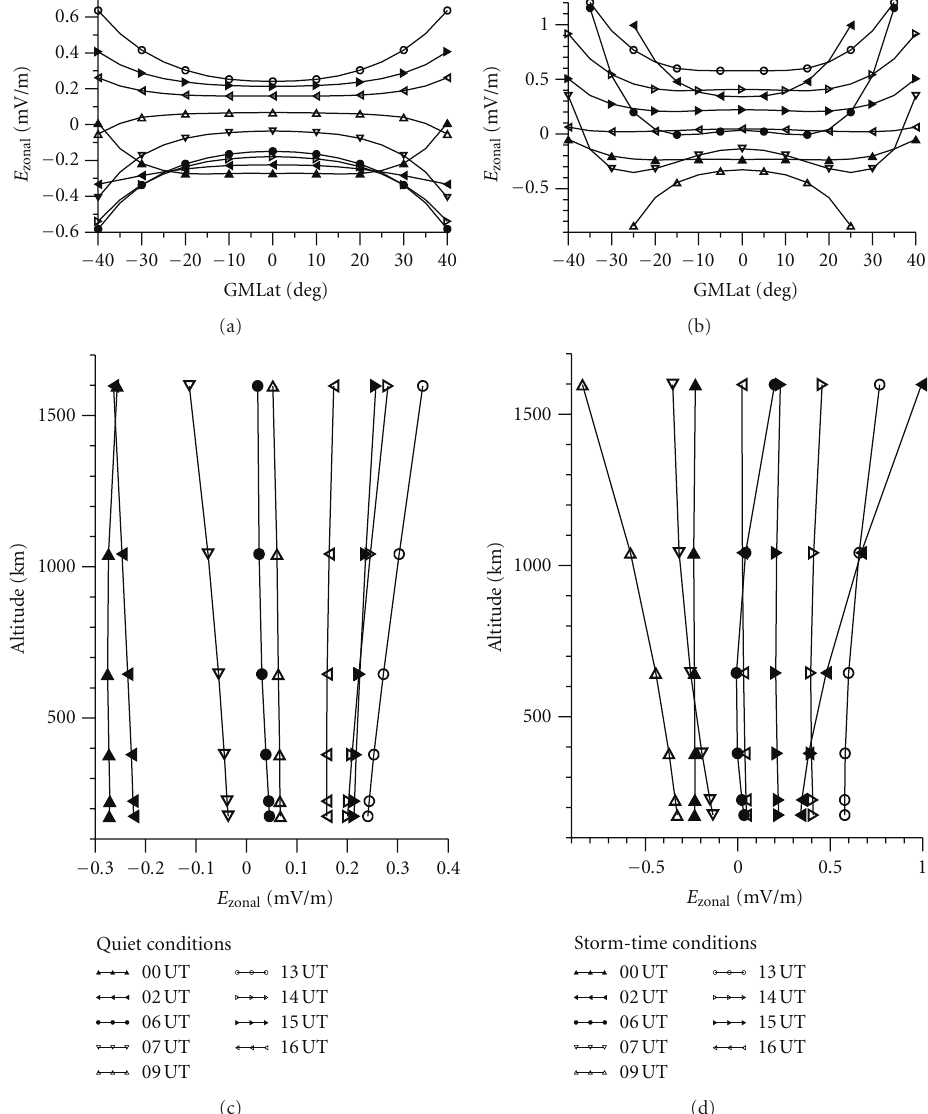
Figure 20: Latitudinal profiles of zonal electric field in the geomagnetic longitude of station Jicamarca (top) and vertical profiles of zonal electric field above station Jicamarca at the di ff erent UT epochs obtained in model calculations for quiet and storm time conditions. (from Klimenko et al.